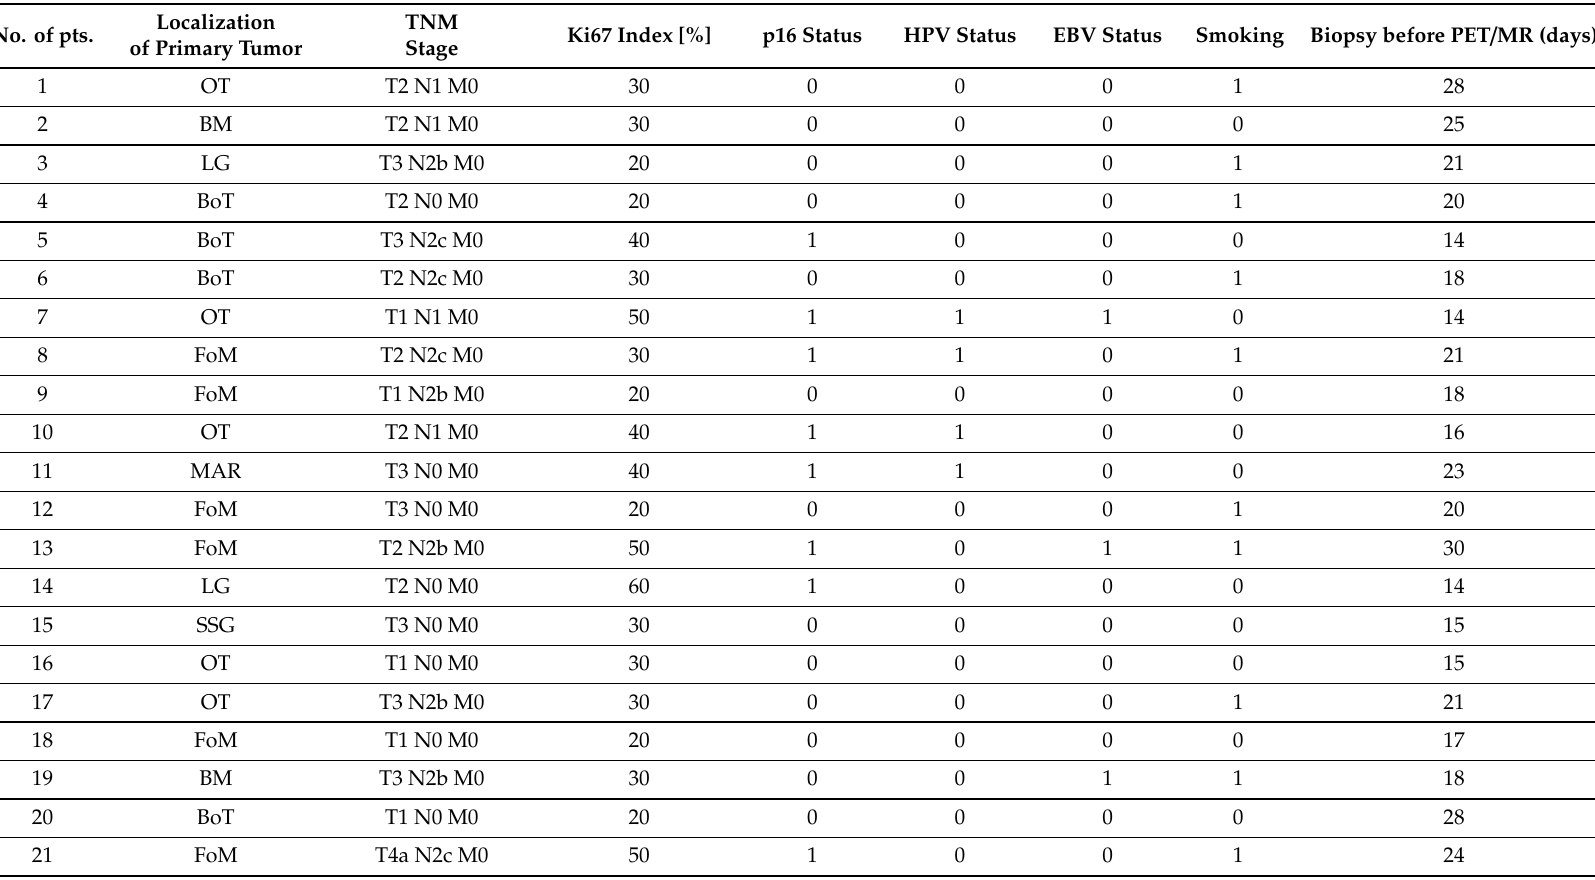
Table 1. Characterization of patient with head and neck squamous cell carcinoma (SSC) according to localization of the primary tumor, Ki67 expression, clinical stage (TNM classification, AJCC, ed. 8, 2017) based on postoperative histopathological (HP) examination, status of p16 protein, human papilloma virus (HPV) and Epstein-Barr virus (EBV) positivity, smoking status and biopsy performed before positron emission tomography / magnetic resonance (PET / MR) imaging. No. of